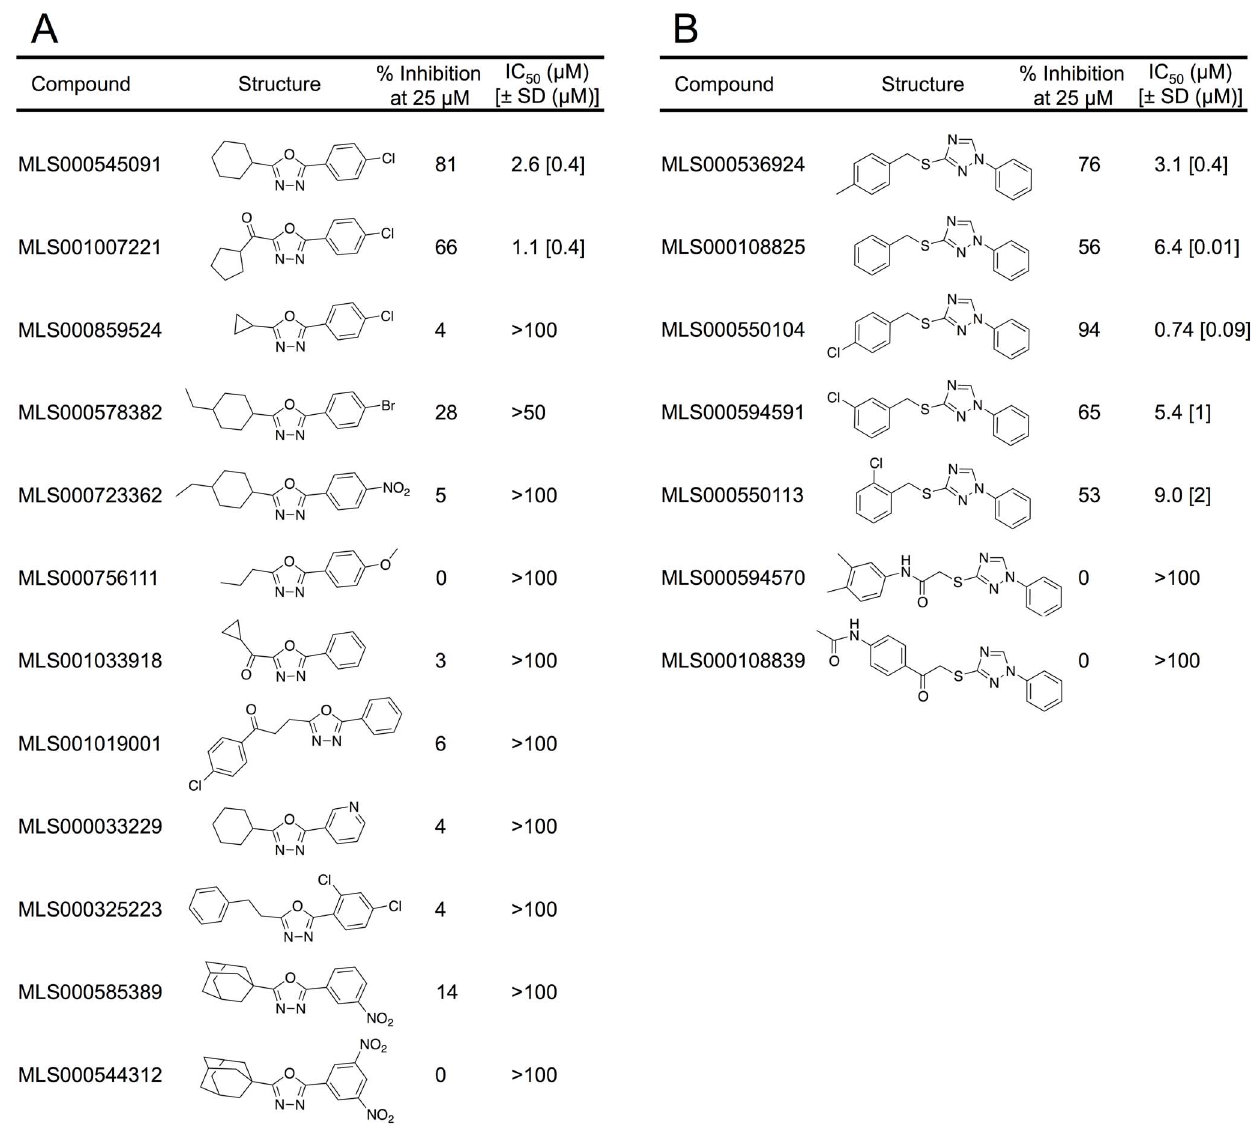
Figure 3. 15-LOX-2 IC 50 values for a few 15-LOX-2 inhibitor analogs, with errors in brackets. (A) MLS000545091 analogs. (B) MLS000536924 analogs. The UV-based manual inhibition data (3 replicates) were fit as described in the Materials and Methods section.